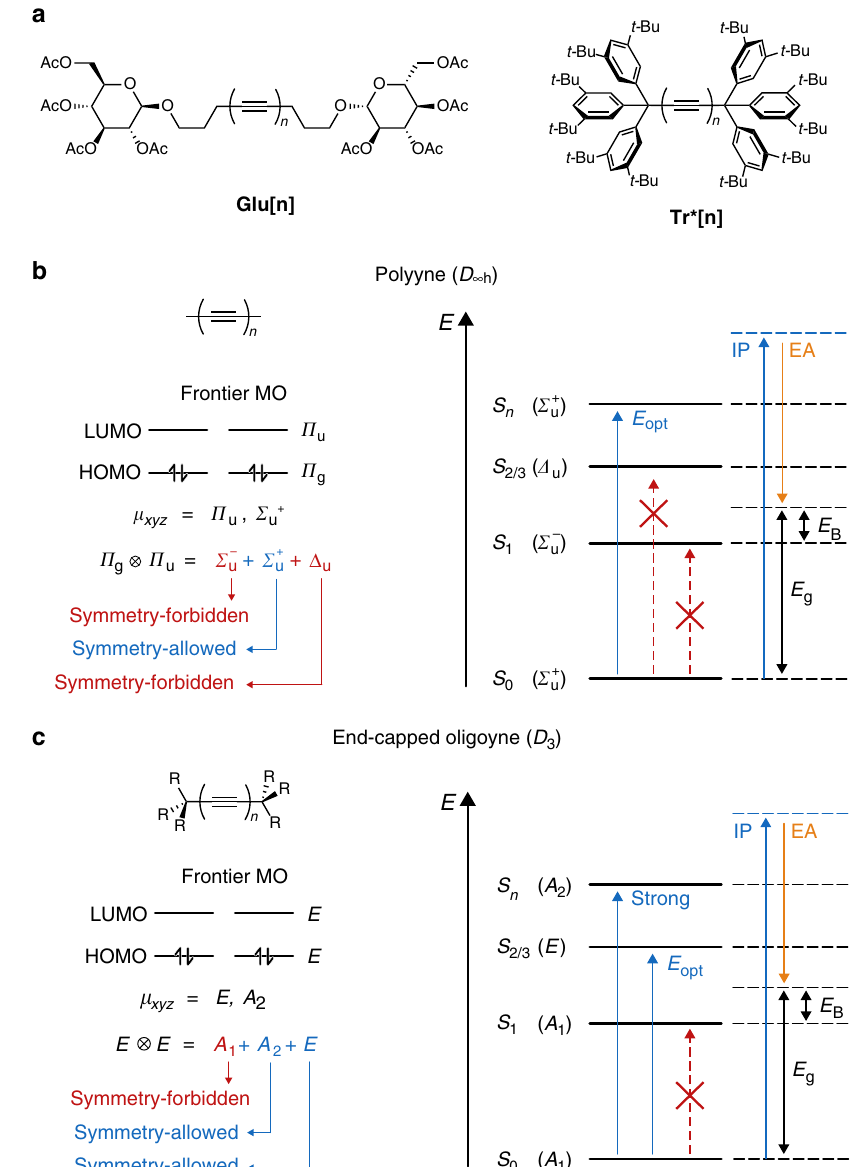
Fig. 1 Oligoynes and their optoelectronic properties. a Chemical structures of the C 2 -symmetric glycosylated oligoynes Glu[ n ] , as well as the D 3 - symmetric oligoynes Tr*[ n ] featuring triarylmethyl endcapping groups. b , c Graphical representations of the symmetry arguments for the electronic transitions and their respective consequences for the optical gap E opt and the fundamental gap E g for b polyyne ( D ∞ h ) as well as c typical oligoynes R 3 C – (C ≡ C) n – CR 3 (with the ionization potential IP , the electron af fi nity EA , the S 0 → S n transition (strong), and the electron-hole pair binding energy E B ) 45